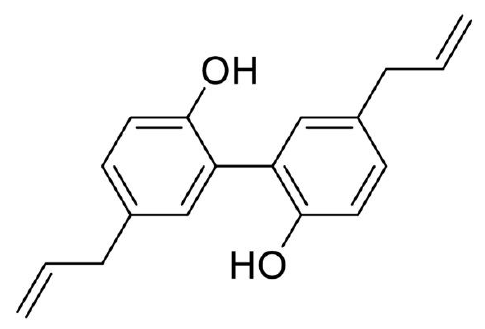
Figure 1. Chemical structure of magnolol.